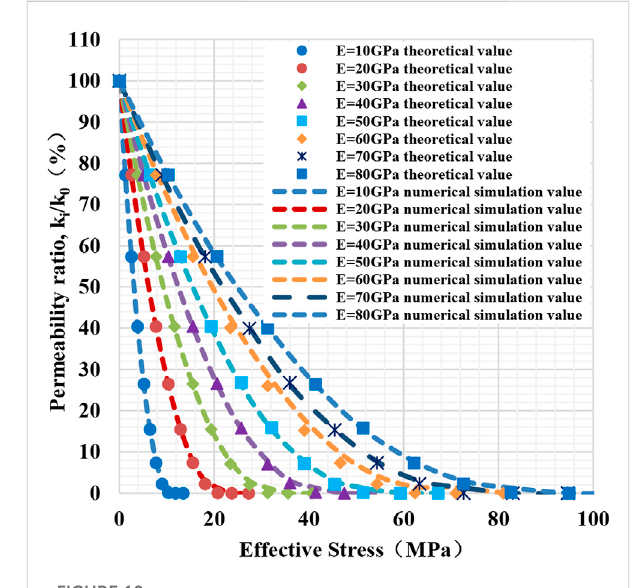
FIGURE 10 Curve of permeability ratio of fractures with different elastic modulus changing with effective stress.